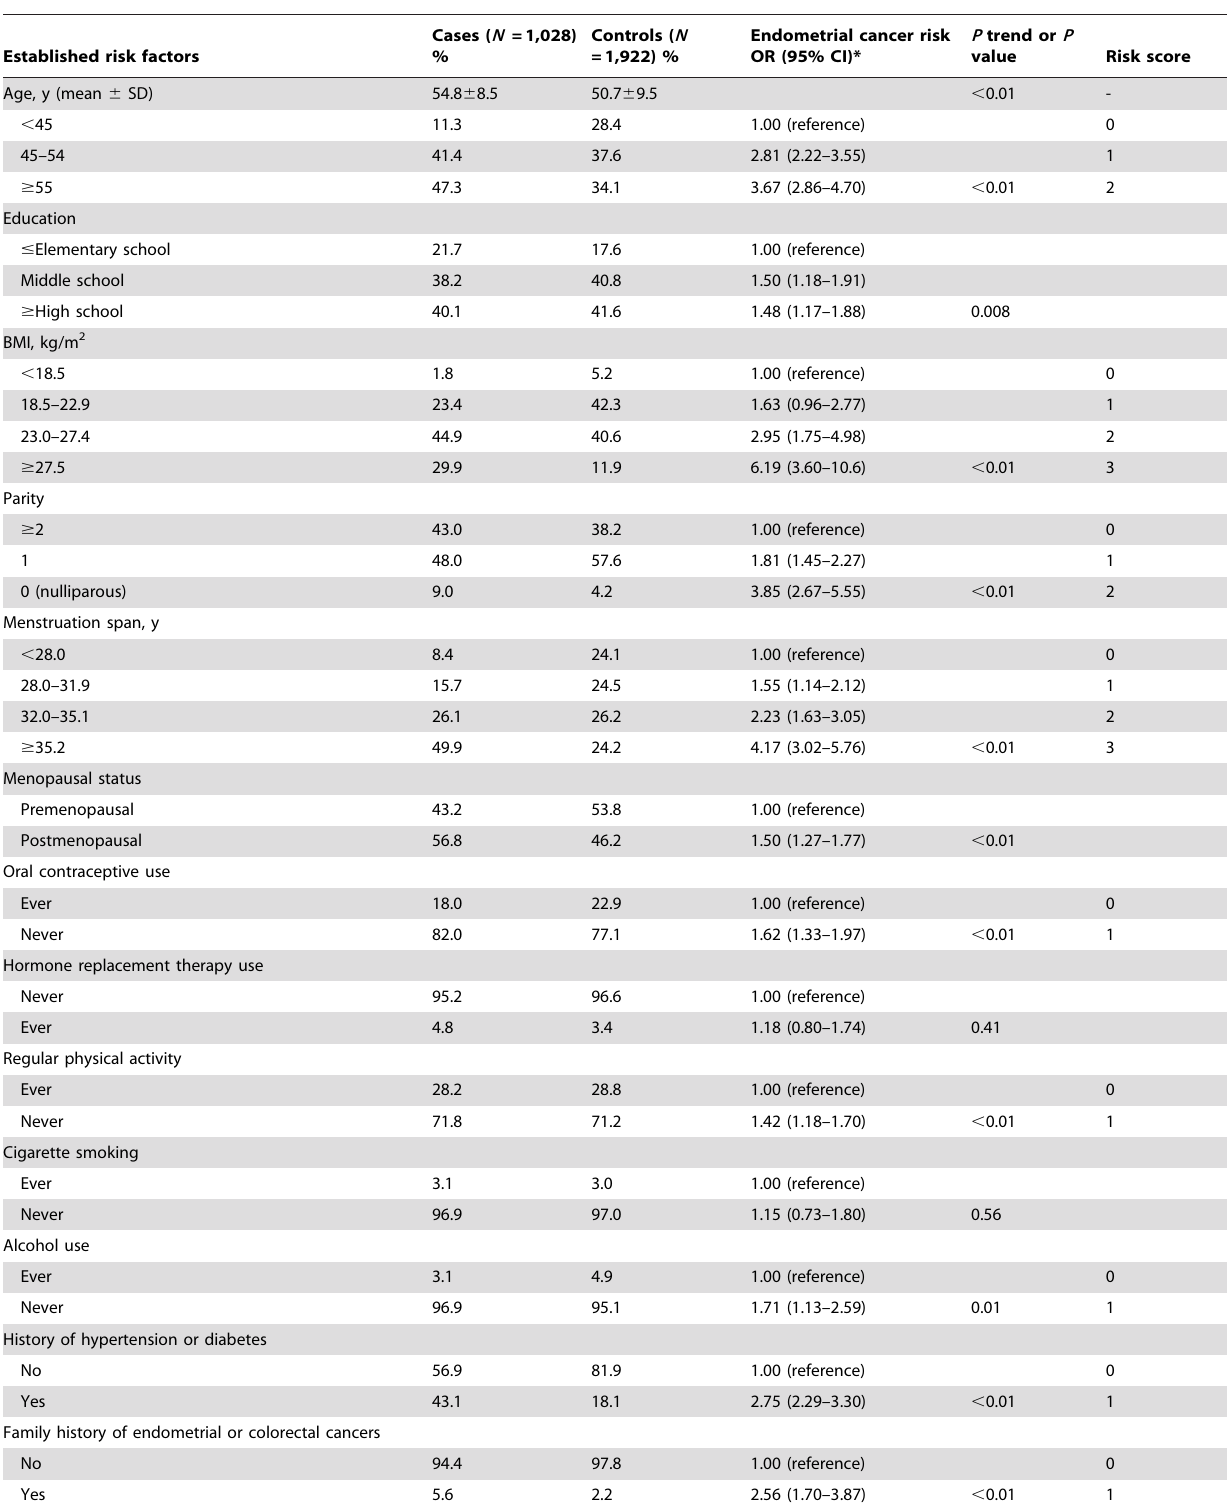
Table 1. Associations of endometrial cancer with established risk factors, the Shanghai Endometrial Cancer Genetics Study (SECGS), 1996 to